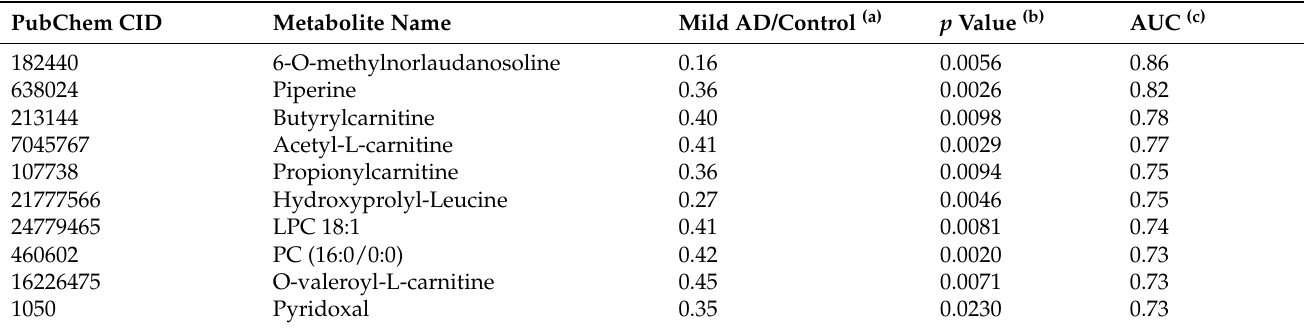
Table 2. Statistically significant metabolites between 14 AD patients (CDR score of 0.5) and 24 controls using untargeted metabolomics analysis.